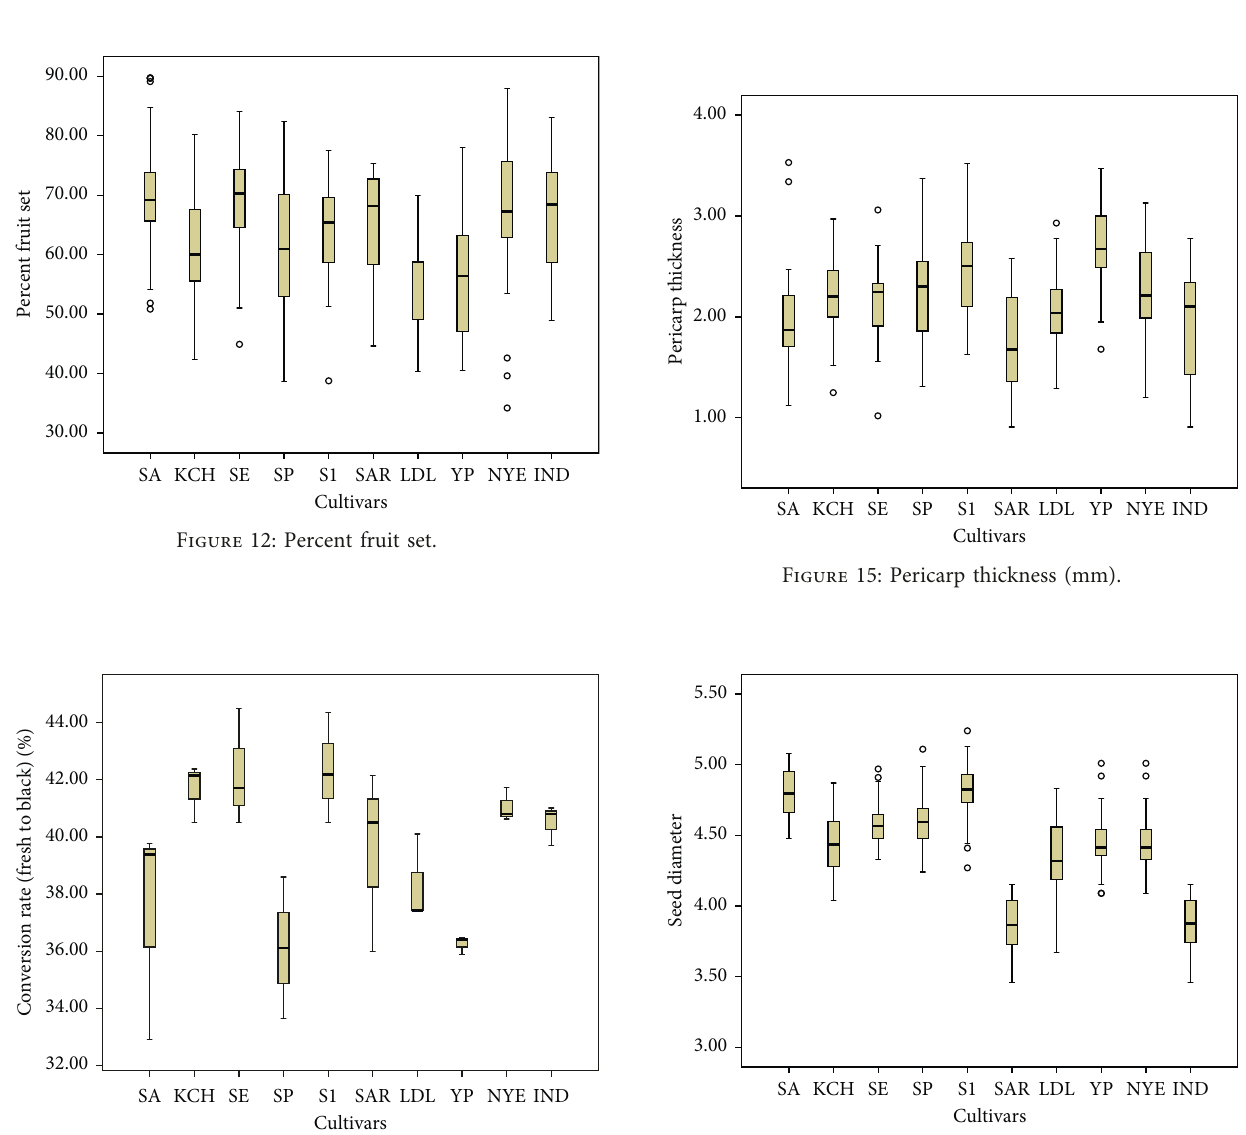
Figure 13: Conversion rate (fresh to dried black pepper) (%).